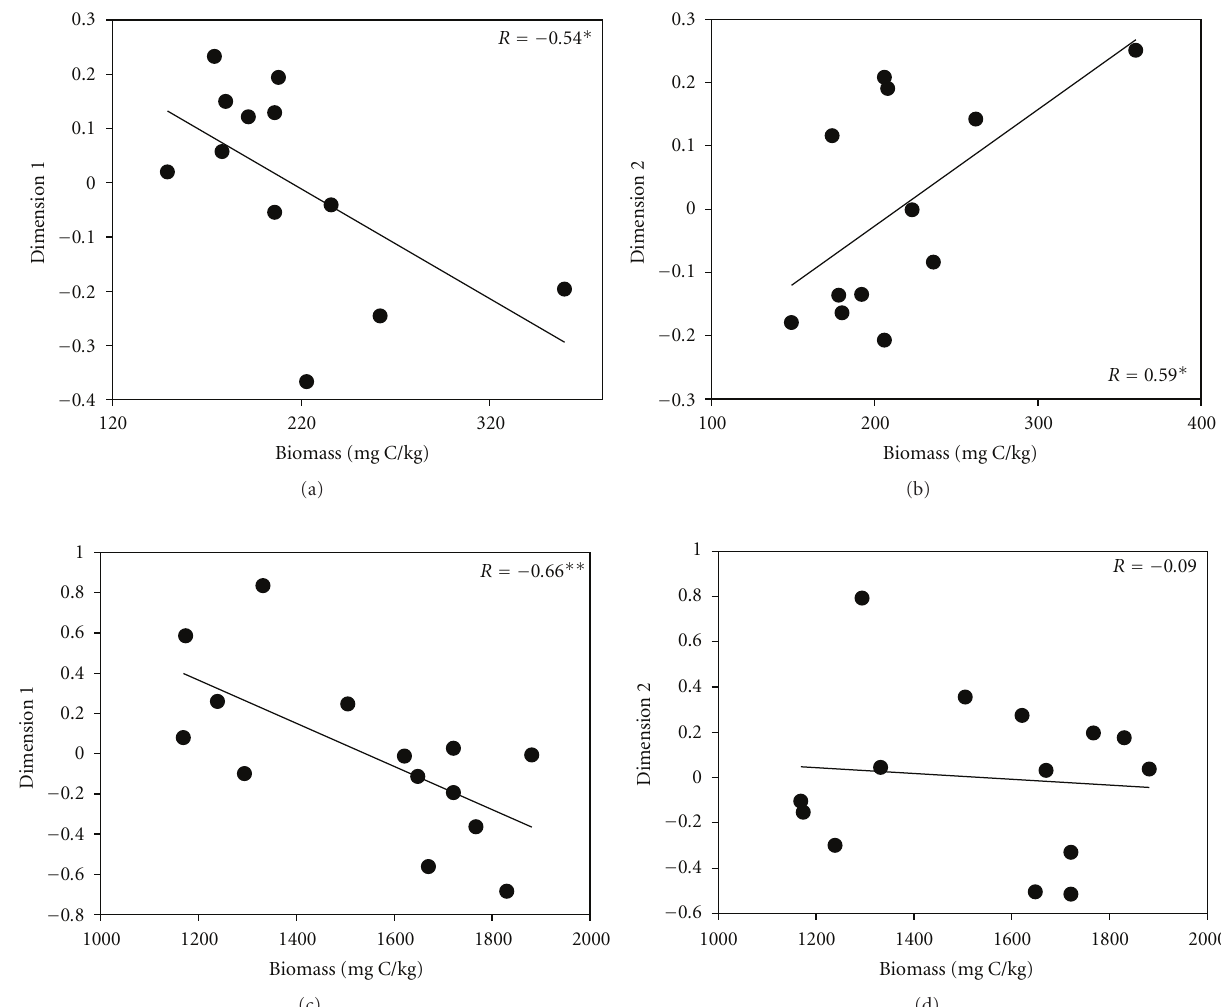
Figure 5: Scatter plots, trendlines, and Pearson correlation coe ffi cients between MBC and dimensions 1 and 2 from NMDS analysis of CD DDGE profiles from organic farm in August (a, b) and pasture days 0, 21, 40, and 63 between May and September (c, d). Significant correlations are indicated by ∗∗ P < 0 . 01 and ∗ P < 0 .